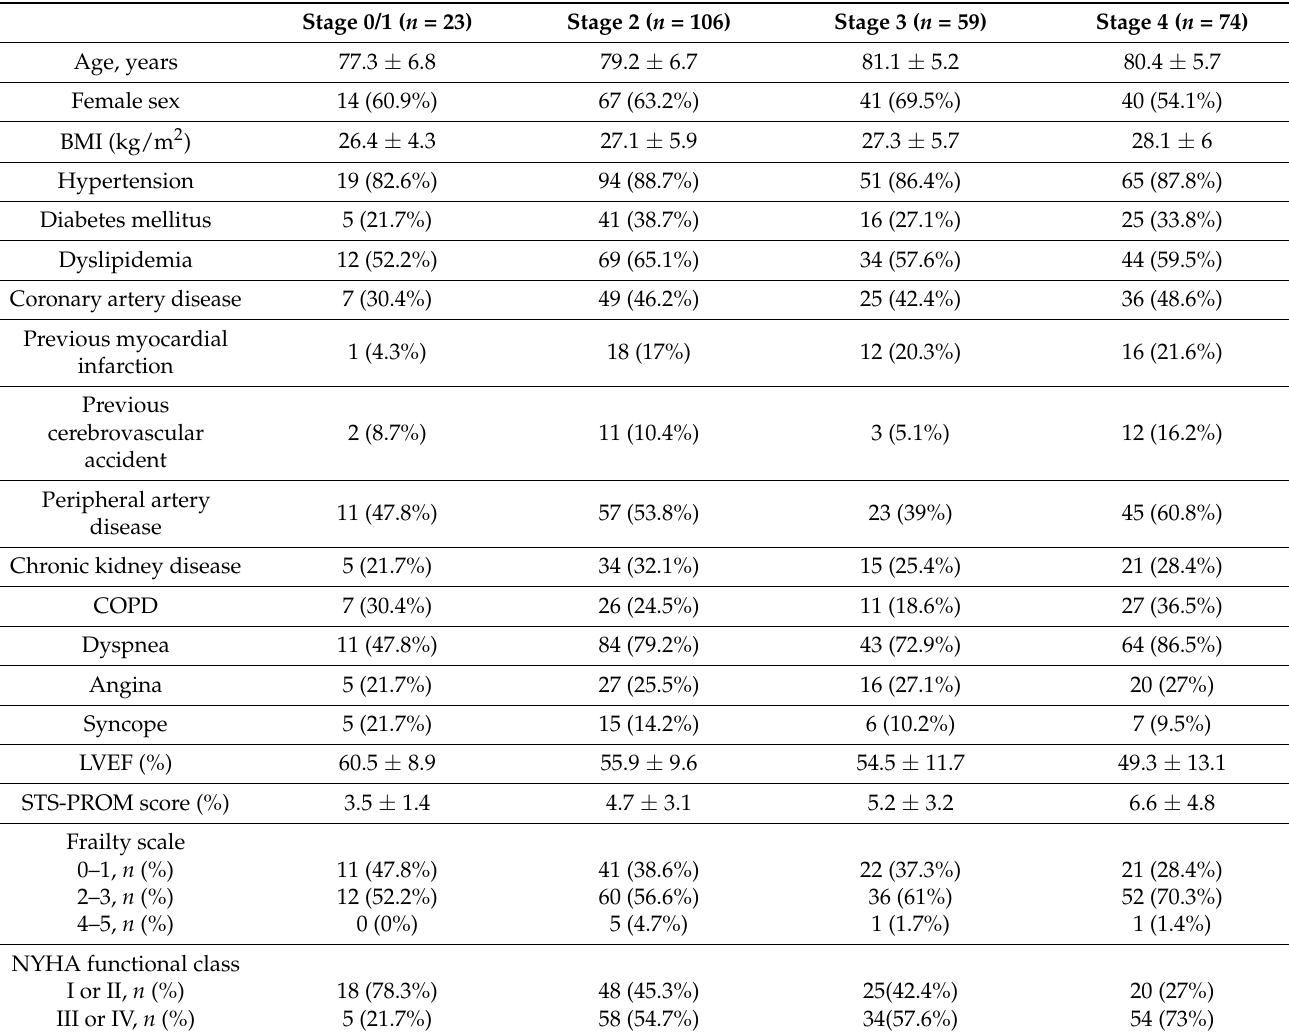
Table 1. Baseline characteristics of patient population according to the stage of cardiac